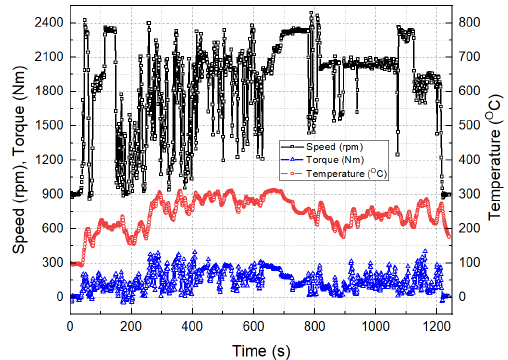
Figure 3. Schematic diagram of the engine dynamometer apparatus.